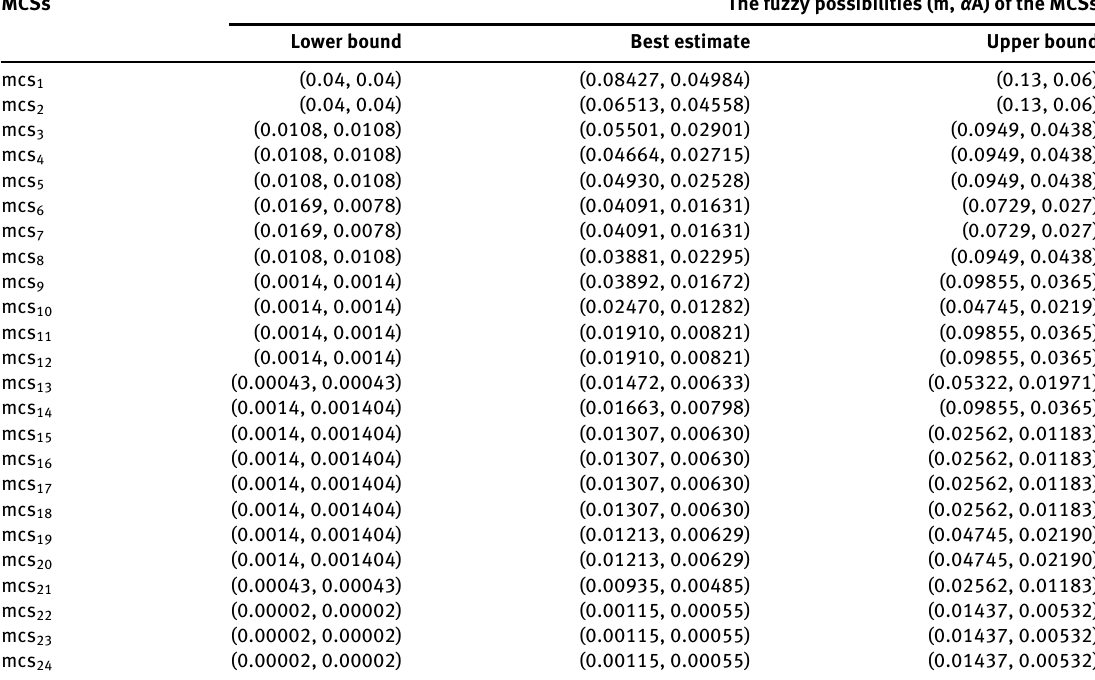
Table 9: The Best Estimate, Lower Bound, and Upper Bound Fuzzy Possibilities of the MCSs of the CERPS Group 1 Fault Tree.